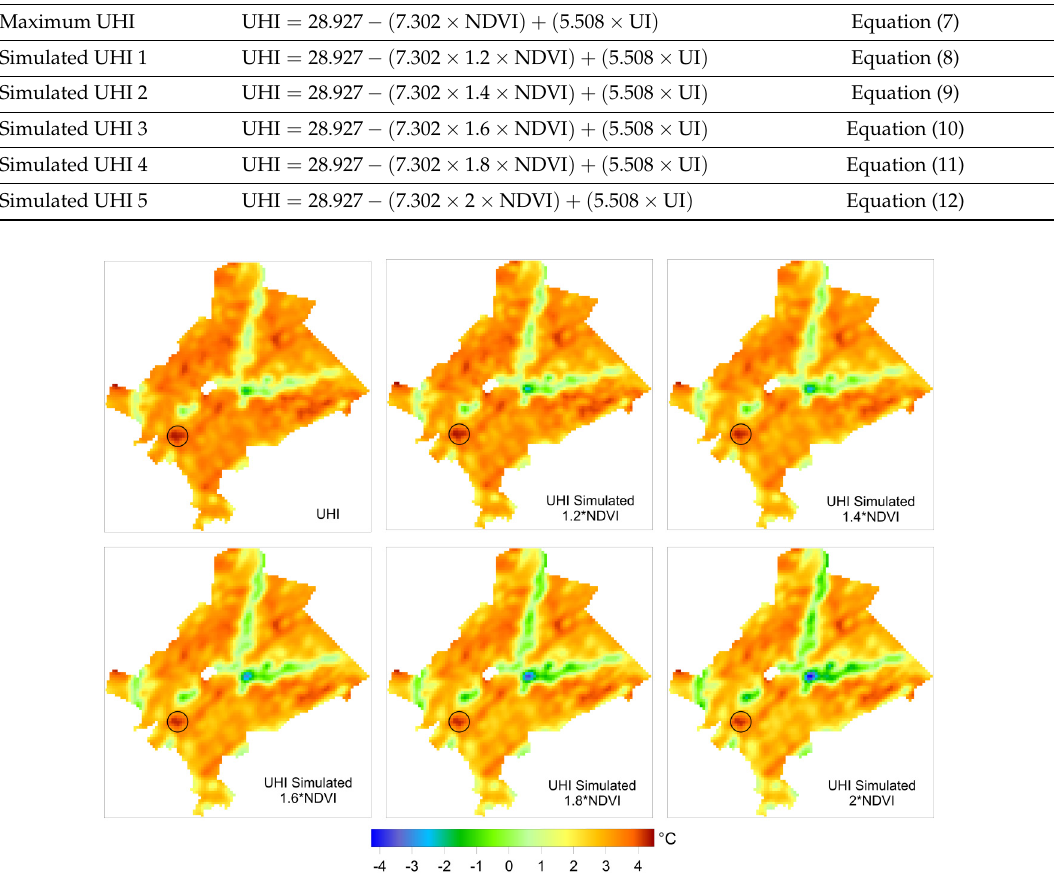
Figure 9. Simulations of spatial patterns of heat islands with increases in NDVI. Table 4. Simulated UHI intensity statistics with NDVI increases.